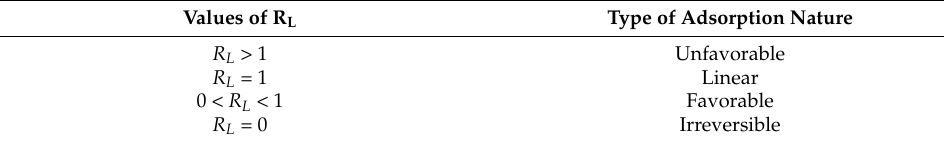
Table 10. Rules for judging the type of adsorption isotherm by R L value.